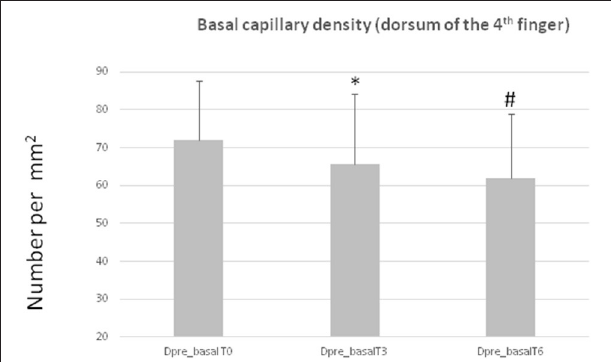
FIGURE 2 | Basal capillary density in the dorsum of the 4th finger (Dpre_basal) at the different time points (T0, T3, T6). *T3 vs. T0 p = 0.03; #T6 vs. T0 p = 0.02. Data are expressed as mean + standard deviation.